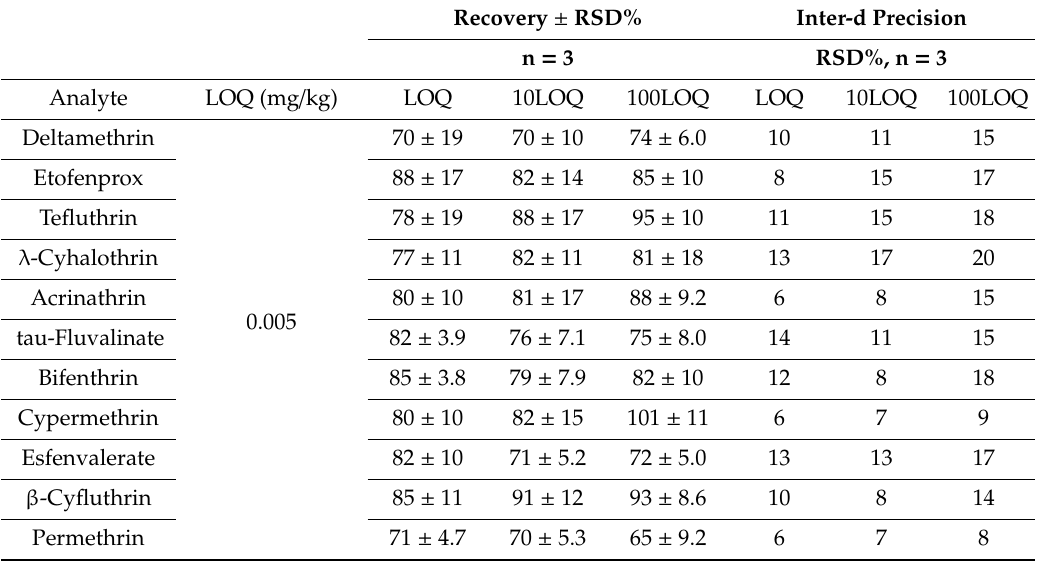
Table 2. Method performance and validation for pyrethroids using GC-EI-QqQ-MS: Limit of Quantitation (LOQ), Recoveries (%), Repeatability (RSD%) and Inter-day (Inter-d) precision (RSD%) obtained in